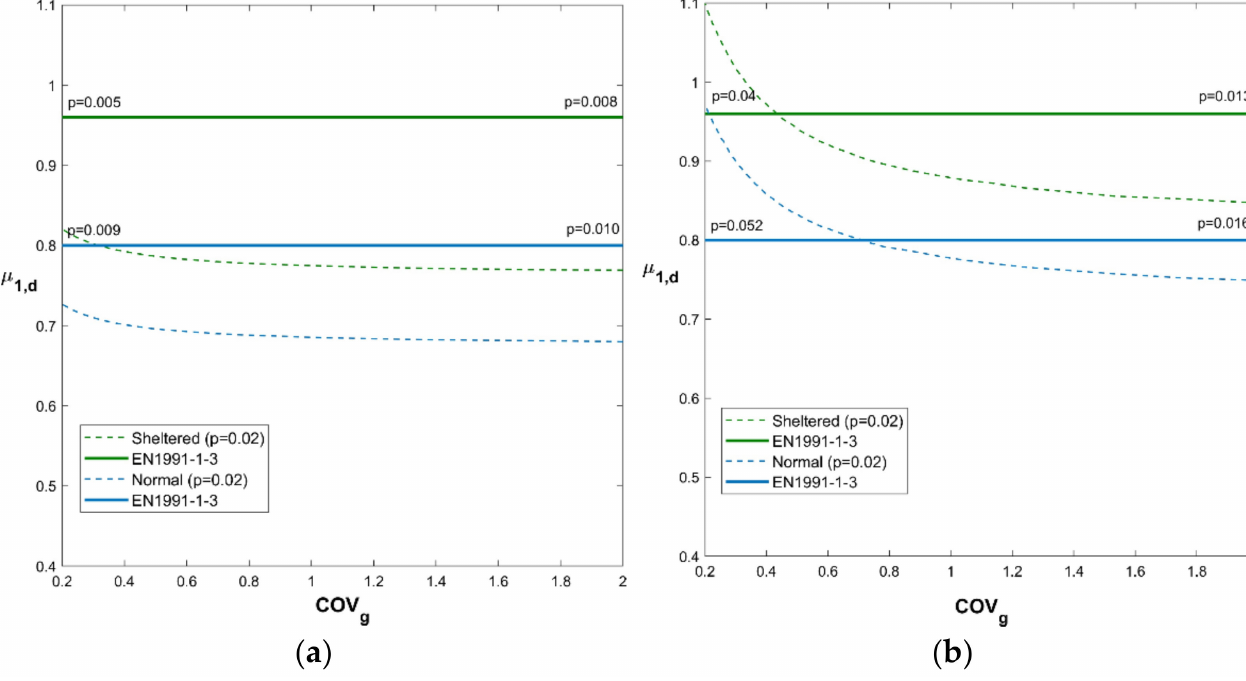
Figure 5. Design shape coefficient for flat roofs ( µ 1, d ) as a function of the coefficient of variation of ground snow load ( COV g ), parameterized in terms of exposure conditions (sheltered: green lines, normal: blue lines). ( a ) Norwegian database; = ( b ) Norwegian database assuming COV µ 1